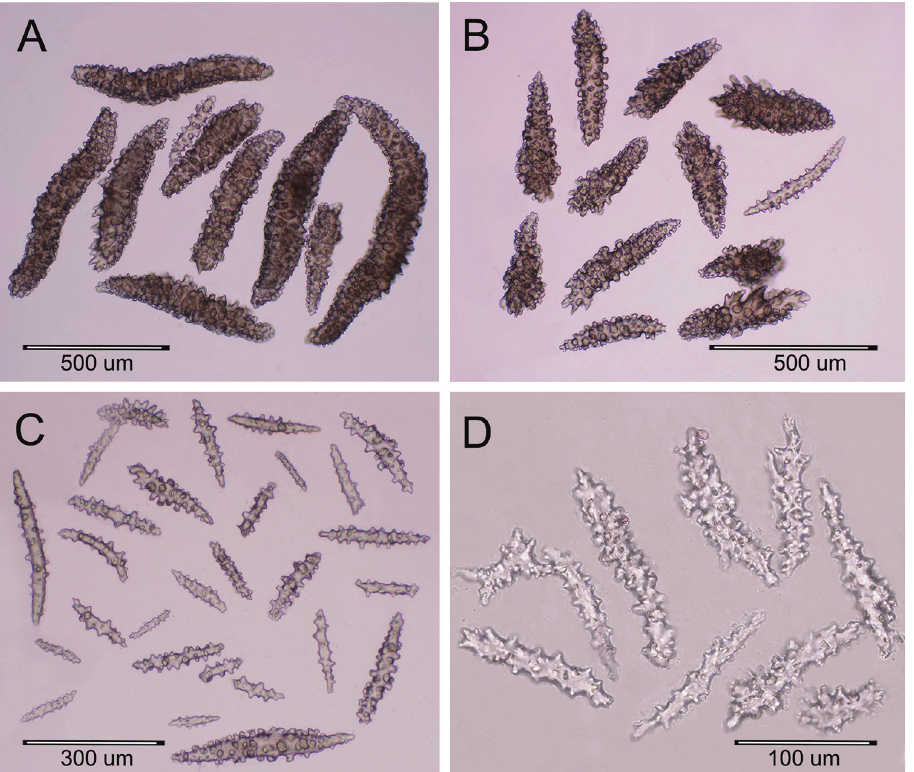
Figure 2. Muricea subtilis sp. n., UCR 2322 (holotype). A–C Coenenchymal sclerites D Anthocodial sclerites (optic